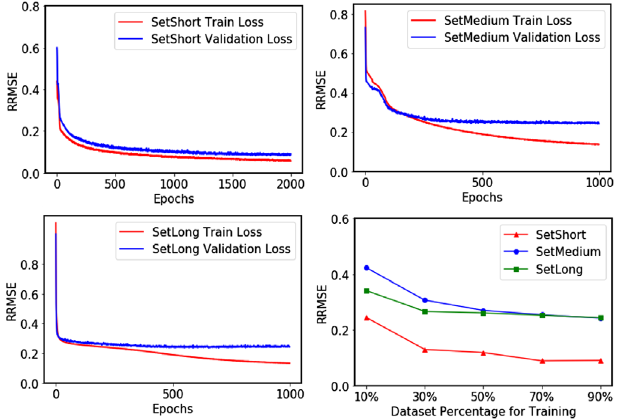
7. The three CNN models are trained until the validation loss (blue lines) converges. The bottom right plot gives the validation loss as a function of training dataset Figure 7 shows the evolution of the loss function for the training and validation sets as a function of epoch. The training is terminated after the validation loss converges to prevent overfitting the training dataset. The black curve is the final validation loss when training on different dataset sizes (five marks represent 10%, 30%, 50%, 70% and 90% of the whole dataset). The convergence with increasing training sample size suggests that additional samples will not help significantly.